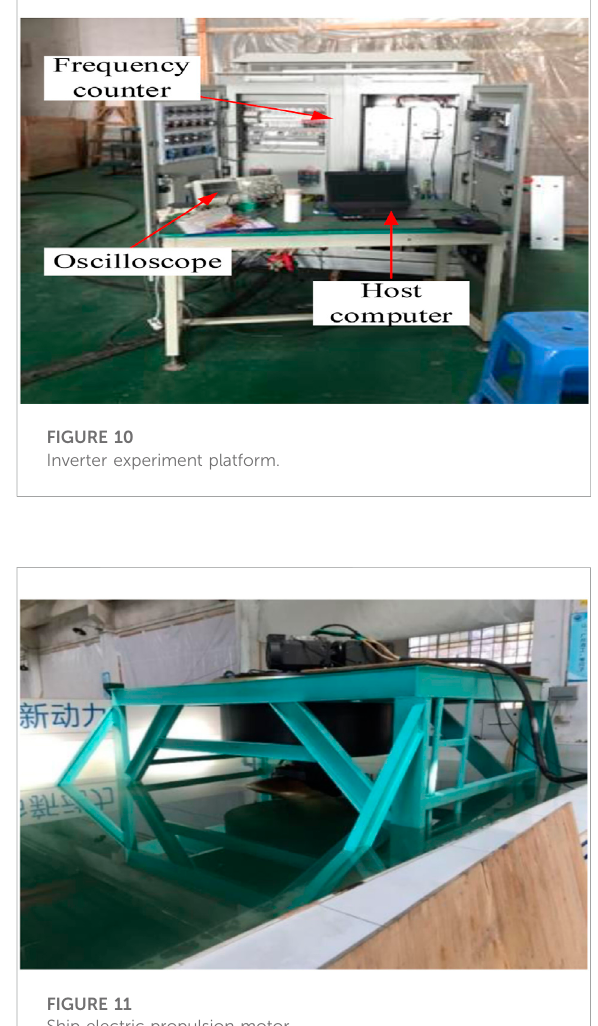
FIGURE 11 Ship electric propulsion